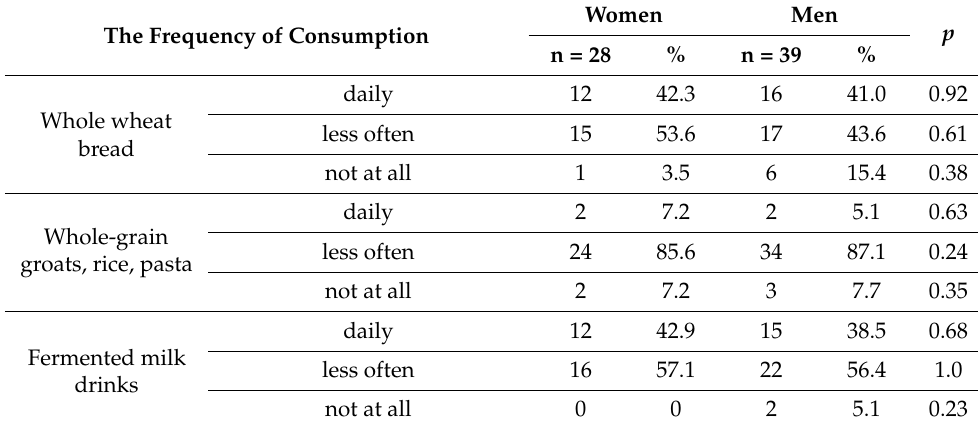
Table 4. The frequency of consuming food products recommended in the study group of patients by gender (n = 67). * 65 people answered this